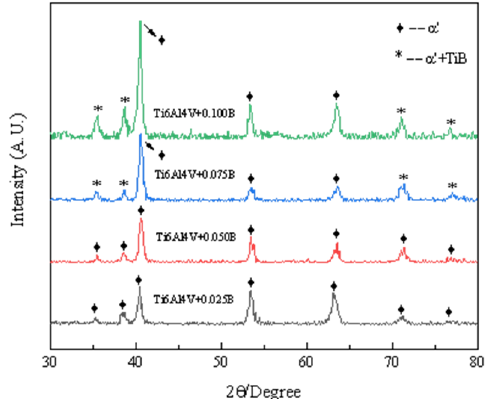
Figure 3. XRD analysis graph.